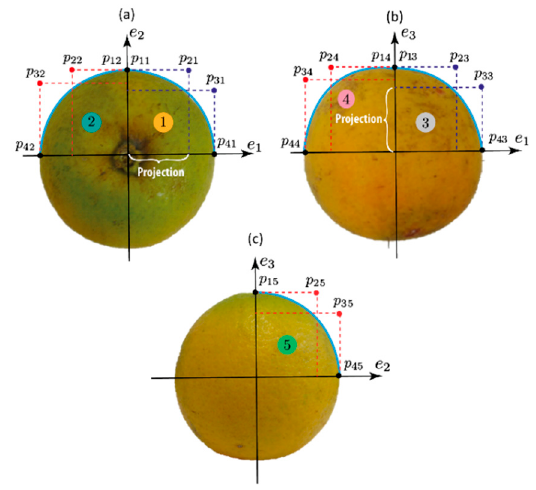
− e − e − e 2 . ( b ) e 1 3 . ( c ) e 2 3 .